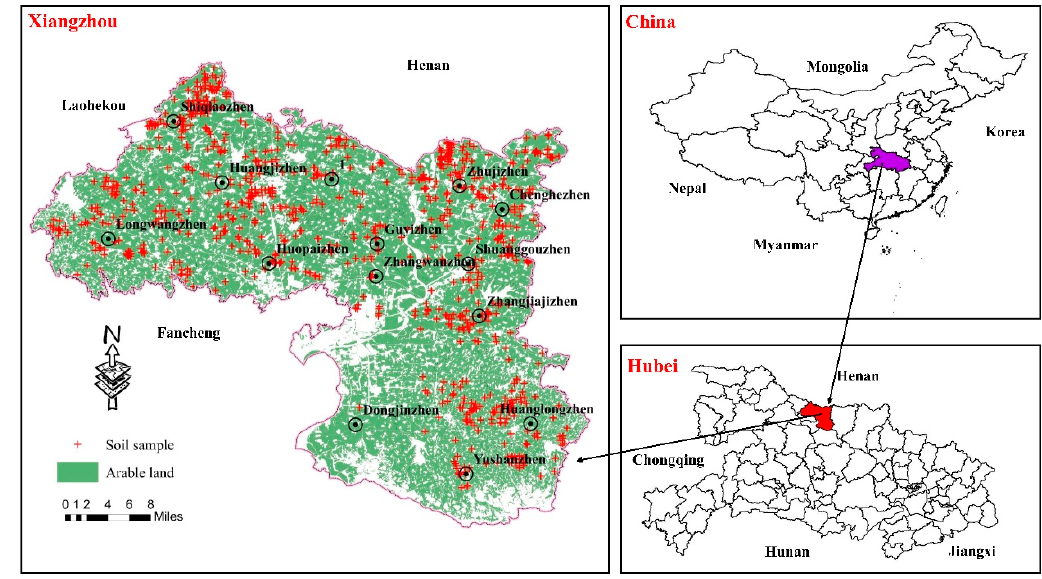
Figure 1. Soil sampling locations in Xiangzhou.